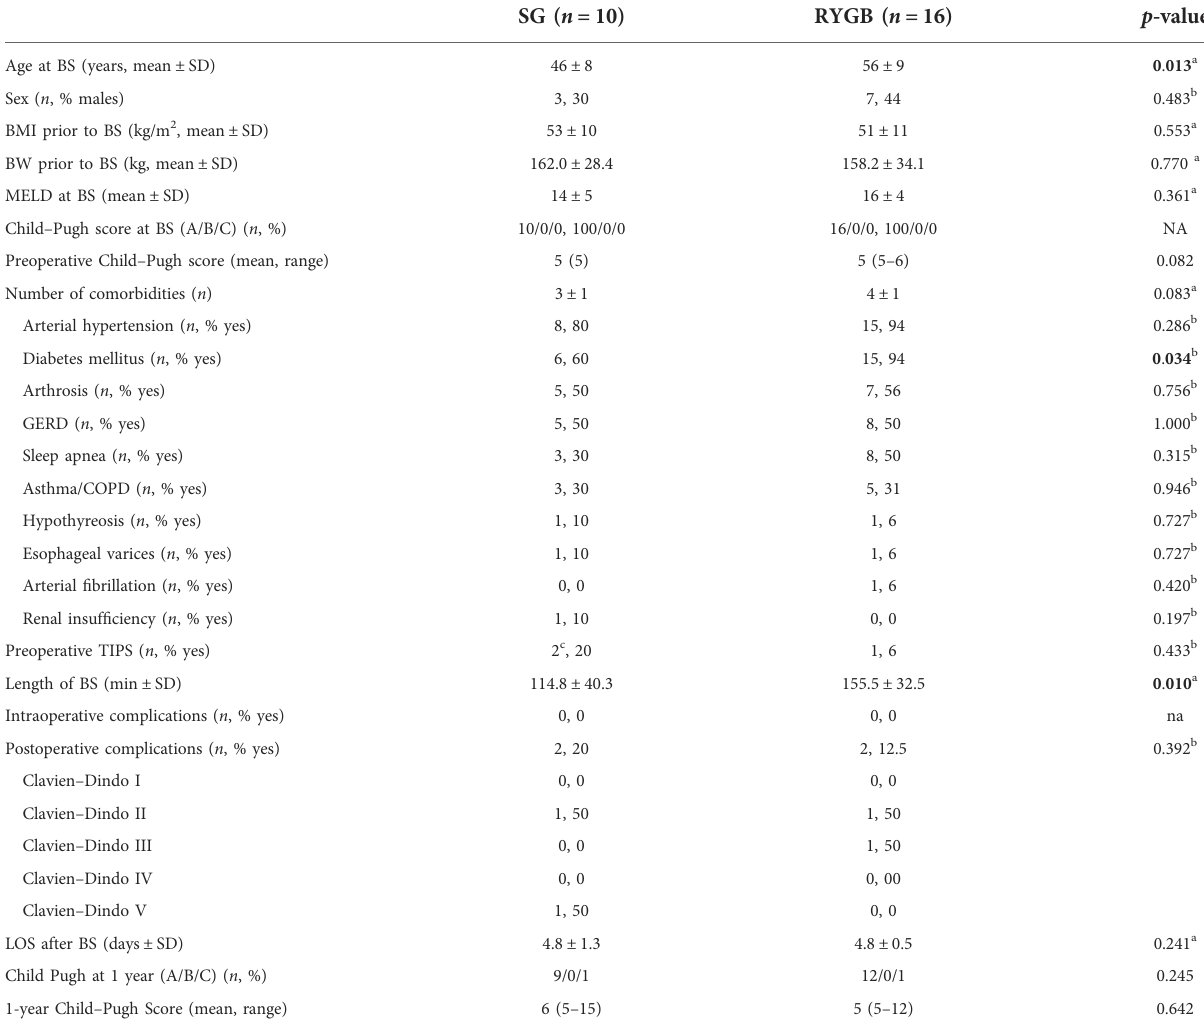
TABLE 2 Comparison of patients receiving BS strati fi ed by bariatric procedure. One patient was excluded due to another procedure type (Omega- Loop), impossible to fi t into the